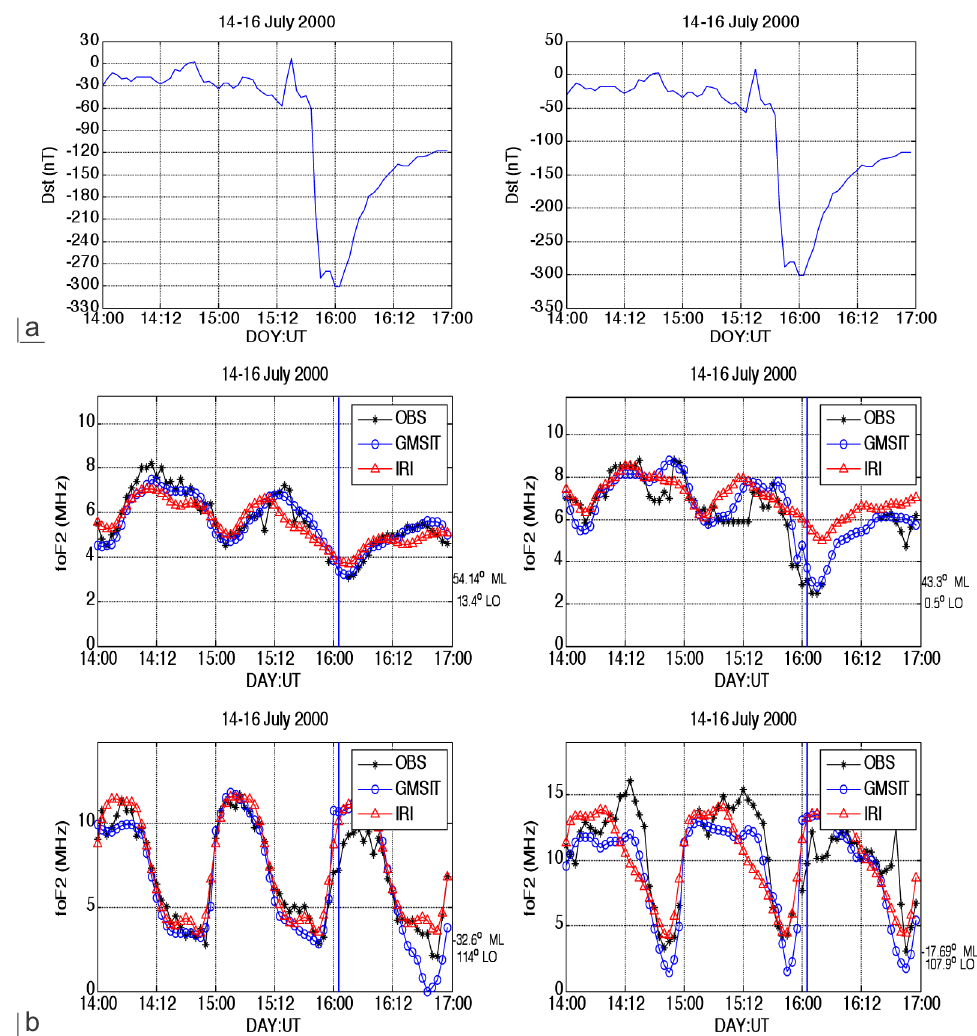
Figure 3. Diurnal variation of (a) Dst index and (b) foF2 estimated by GMIST, IRI and ionosonde observations on July 15-16, 2000, at ionos- pheric stations of different regions of the globe. The geomagnetic latitude and geographic longitude of each station is given at the low-right edge of each